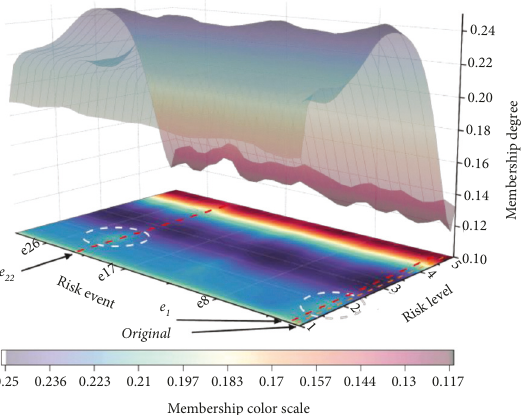
Figure 9: Influence of risk level changes of different events on the overall risk grade of foundation pit under the same weight.